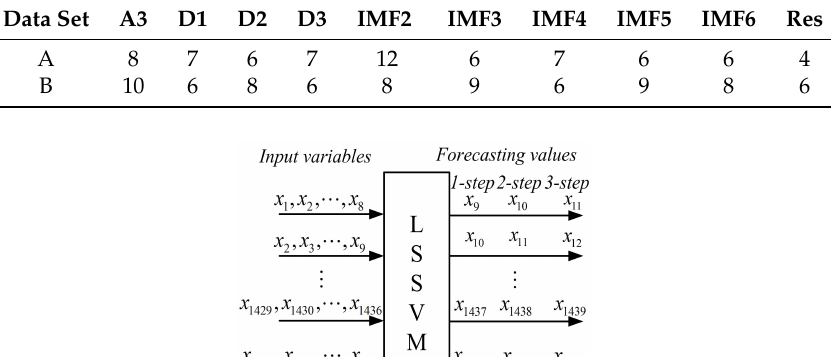
Table 2. Lag values partial autocorrelation function (PACF) for the different subseries.